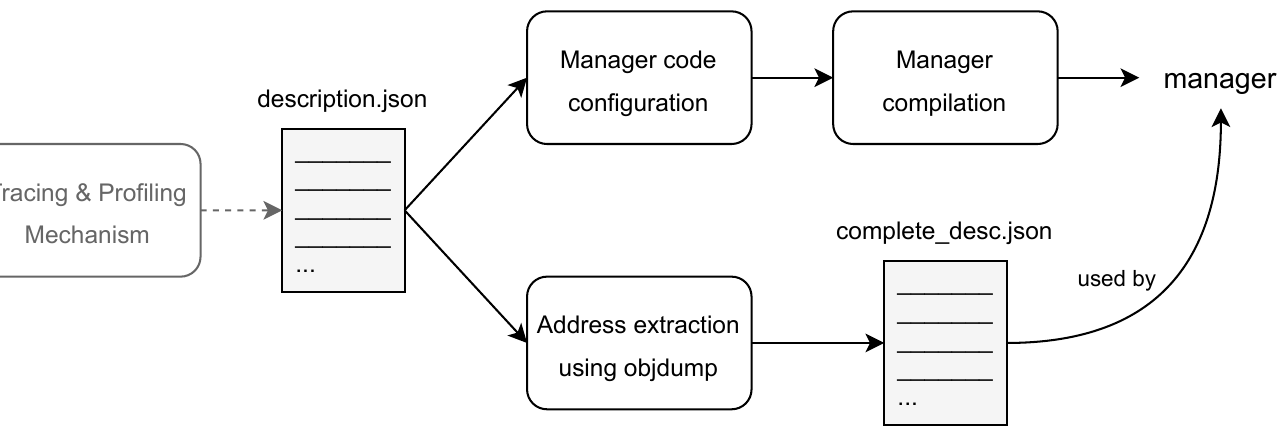
Figure 5. Tool flow for manager configuration.